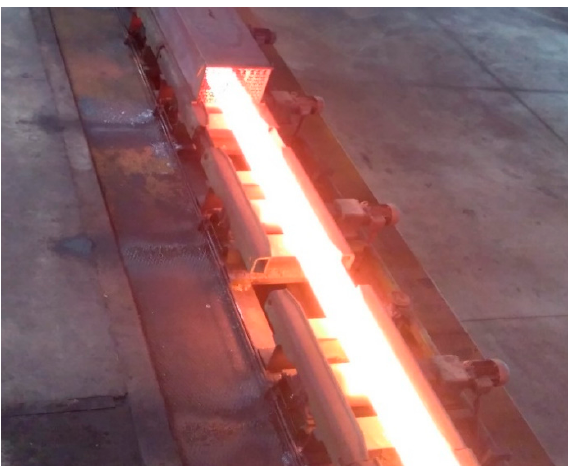
Figure 1. Example of a billet.